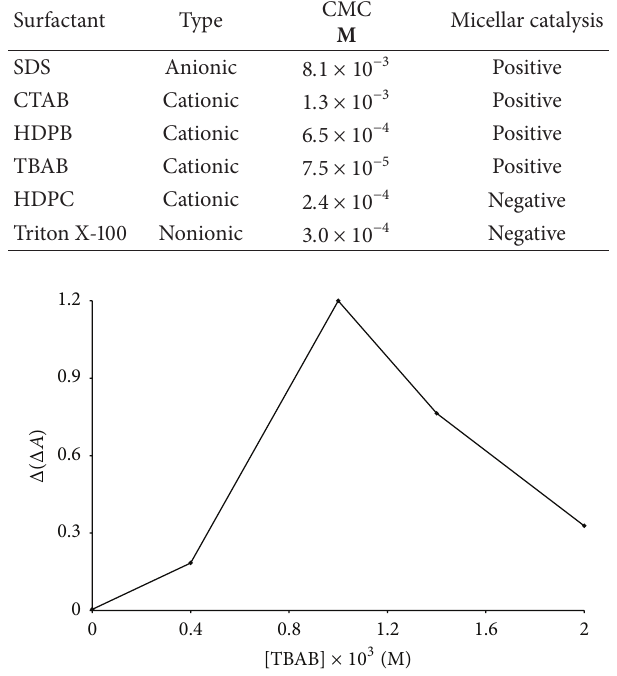
Figure 6: Effect of TBAB on the sensitivity. Conditions: H 2 SO 4 , 2.4 molL −1 ; SCG; 12ng mL −1 ; amaranth, 1.4 × 10 −4 M; IO 4− 4.0 × 10 −4 M; temperature, 25 ∘ C.